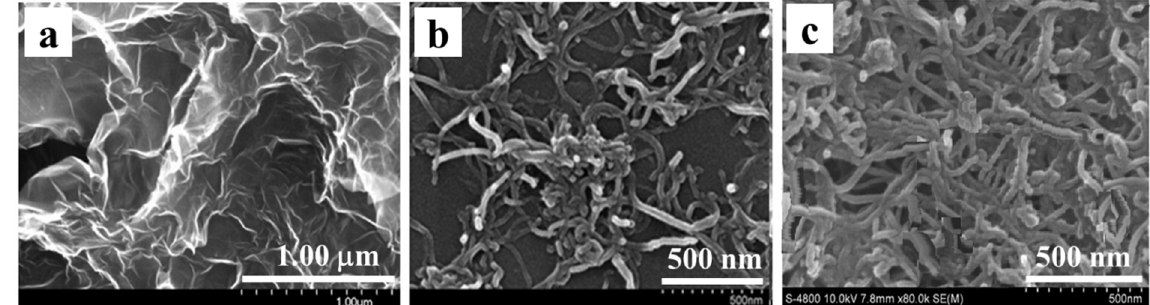
Figure 2. FE-SEM of ( a ) rGO made by the modified Hummers method, ( b ) MWCTs, and ( c ) P3HT-rGO-MWCNTs. XRD characterization of the PGC film shows four peaks. Among them two distinctive peaks (002) and (101) belong to MWCNTs [32]; two other peaks are unidentified (Figure 3). The representative peak of rGO made by the modified Hummers method are immersed in the (002) peak of MWCNTs and obviously, a P3HT amorphous cluster dispersed in a rGO matrix did not exist in XRD pattern.